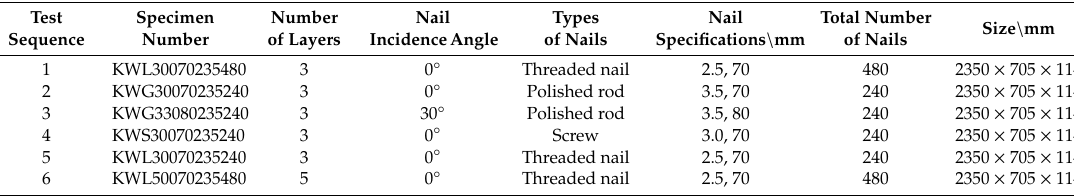
Table 1. Details of test specimen.